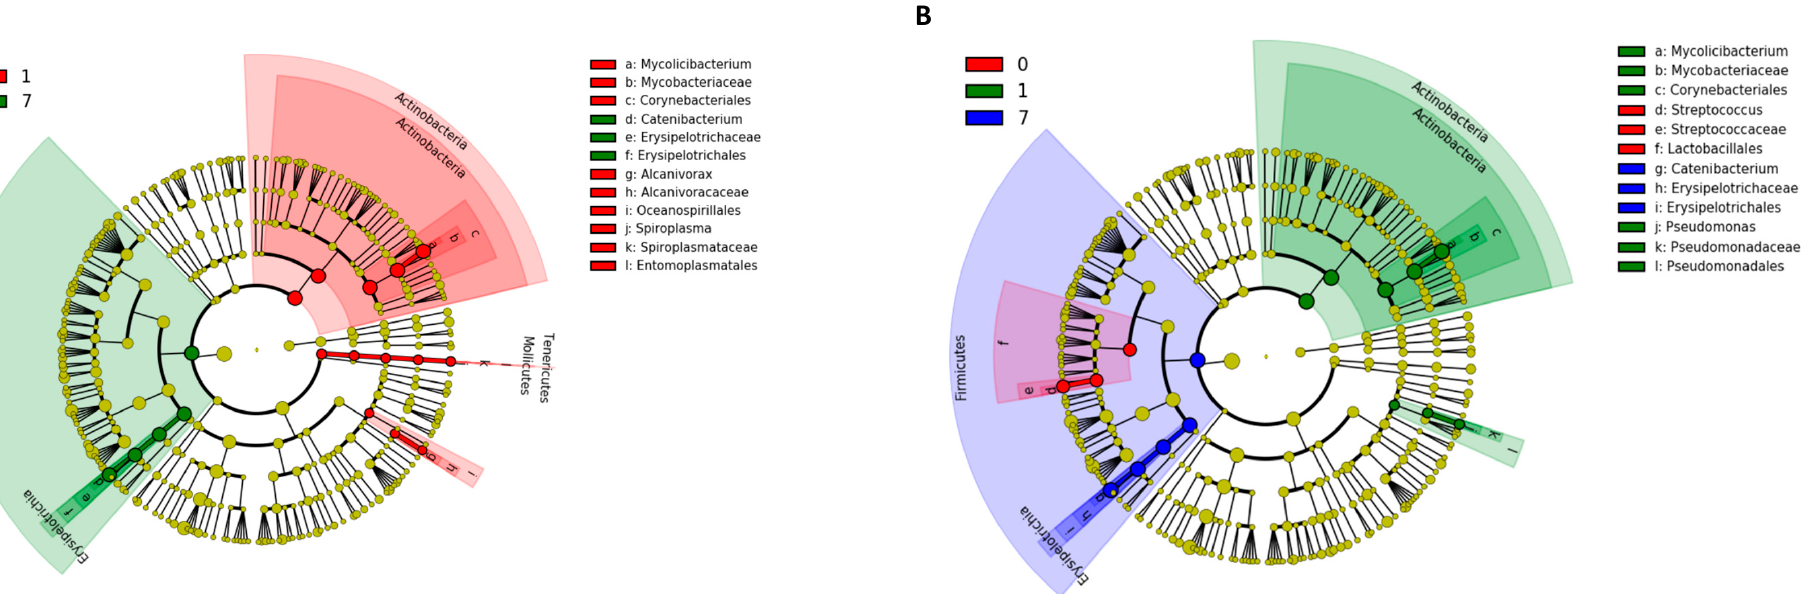
Figure 6. Variation in bacterial species in milk microbiota during 0–7 days on NT-AMT group ( A ) and AMT-AMT group ( B ) treated with antibiotics for mastitis with Gram-positive bacteria. Bacterial species that changed in abundance from the results of the Kruskal–Wallis test using LEfSe analysis. ( A ) Bacterial species that changed in abundance between the days after treatment in the NT-AMT group. There were many Actinobacteria on day 1 and many Firmicutes on day 7. ( B ) Bacterial species that changed in abundance between the days after treatment in the AMT-AMT group. There were many Actinobacteria on day 1 and many Firmicutes on day 7.